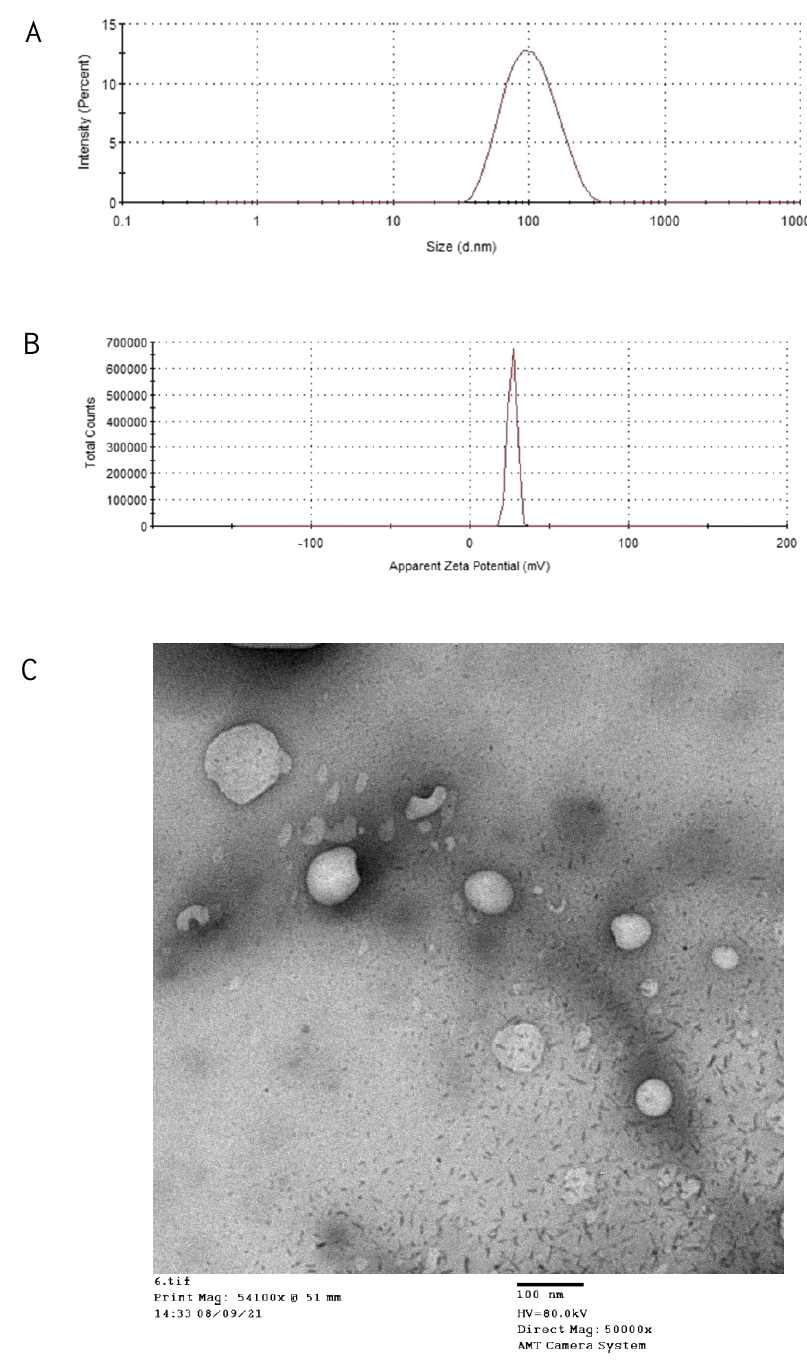
Figure 1. Particle size ( A ), zeta potential ( B ), and TEM image ( C ) of the CTX–MEL complex. TEM results showed spherical bodies with a size range comparable to the size obtained by using the nanosizer. Previous reports indicate that particle sizes < 100 nm achieve maximum cellular uptake [32,33]. Accordingly, CTX – MEL characterization showed promising formula in relation to particle size and zeta potential.